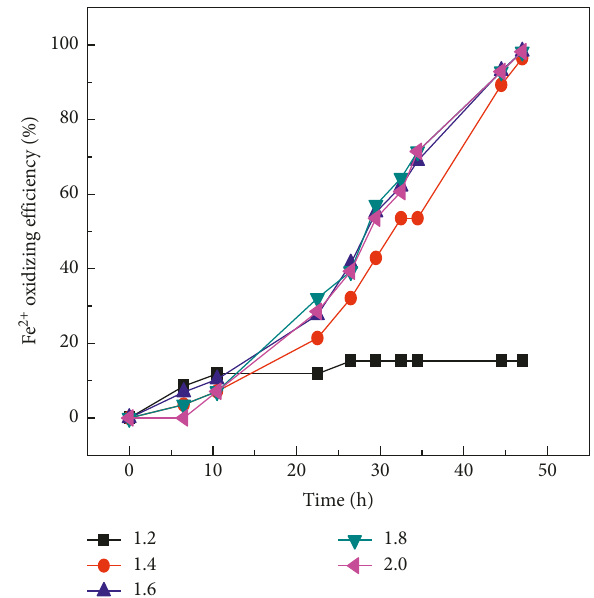
Figure 3: Fe 2+ oxidizing efficiency vs. time at different initial pH values.